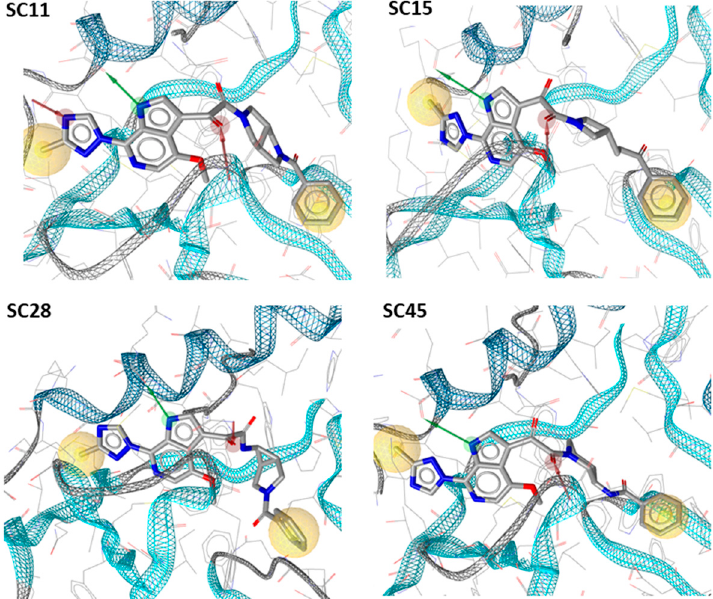
Figure 3. Docking models of compounds SC11 , SC15 , SC28 and SC45 with B41 SOSIP structure PDB 6MUG.